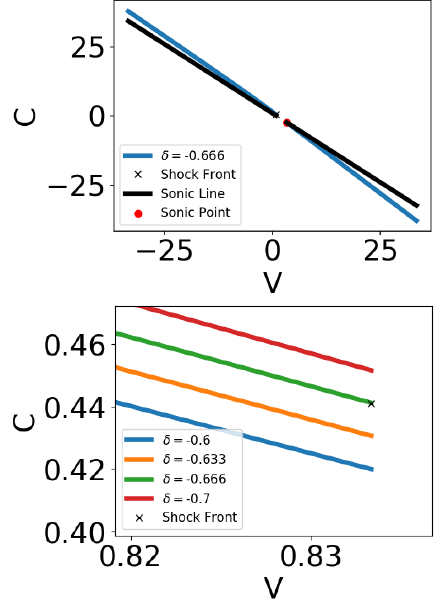
Figure 2. Numerically integrated Hydrodynamic trajectories, integrated from the sonic point (red dot) to the shock front (black cross) for γ = 7/5, as an example for the case 2 > γ > 1, for different values of δ . The entire domain is shown in the top panel, and a zoomed in plot at shock front point is shown in the bottom panel. The integration goes from the sonic point in the fourth quadrant and proceeds down and to the right. After passing through χ = 0 the integration reappears in the second quadrant (top left corner) and travels to the shock front